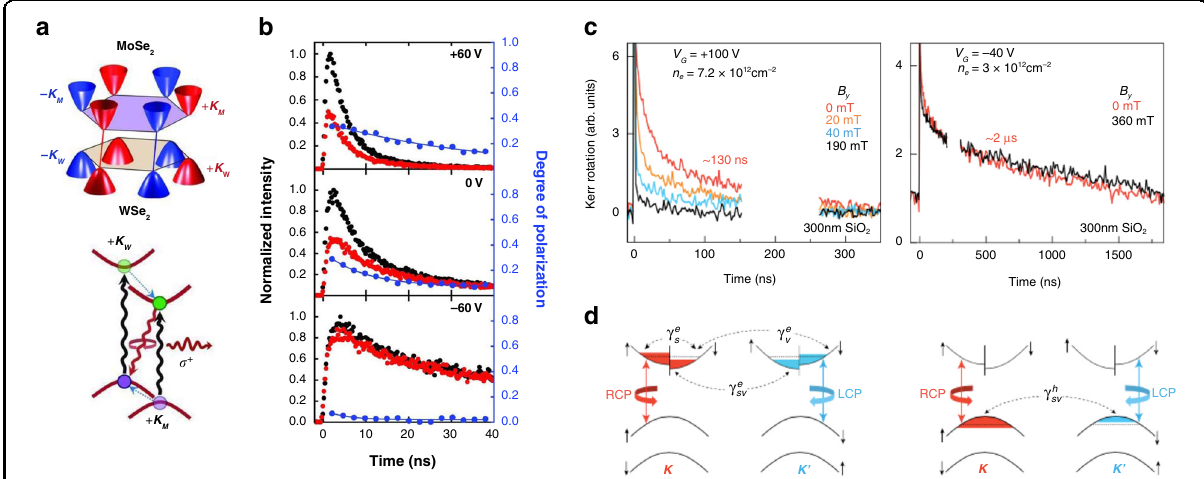
Fig. 9 Valley/spin polarization dynamics of photocarriers in 2D TMDs. a (Top) Illustration of the Dirac points in the hexagonal Brillouin zone of a MoSe 2 /WSe 2 heterostructure. (Bottom) Schematic of the interlayer exciton in the + K valley of the heterostructure. b Time-resolved interlayer exciton PL at selected gate voltages. c (Left) Time-resolved Kerr rotation (TRKR) at 5 K on gated monolayer WSe 2 (left) in the heavily electron-doped regime at the negatively charged exciton transition and (right) in the hole-doped regime at the positively charged exciton transition. d Diagrams depicting the simplest WSe 2 band structure in the (left) electron-doped and (right) hole-doped regimes, along with available scattering pathways. Figure reproduced with permission from a , b ref. 98 , © 2016 AAAS; c , d ref. 101 , © 2017 American Physical